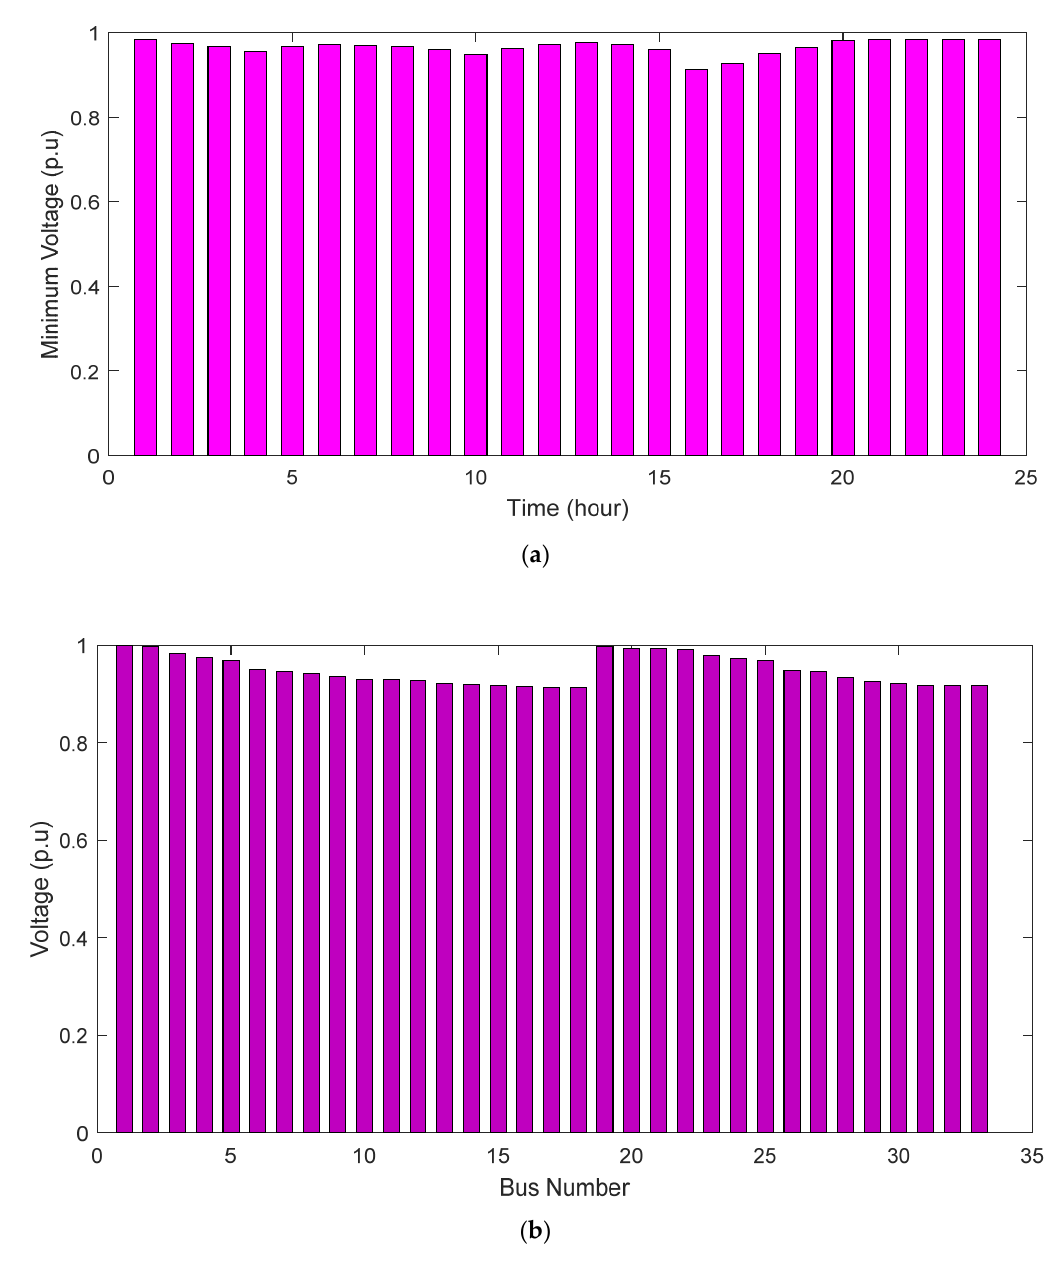
Figure 8. ( a ) Minimum voltage of base network for 24 h; ( b ) Voltage profile of base network.